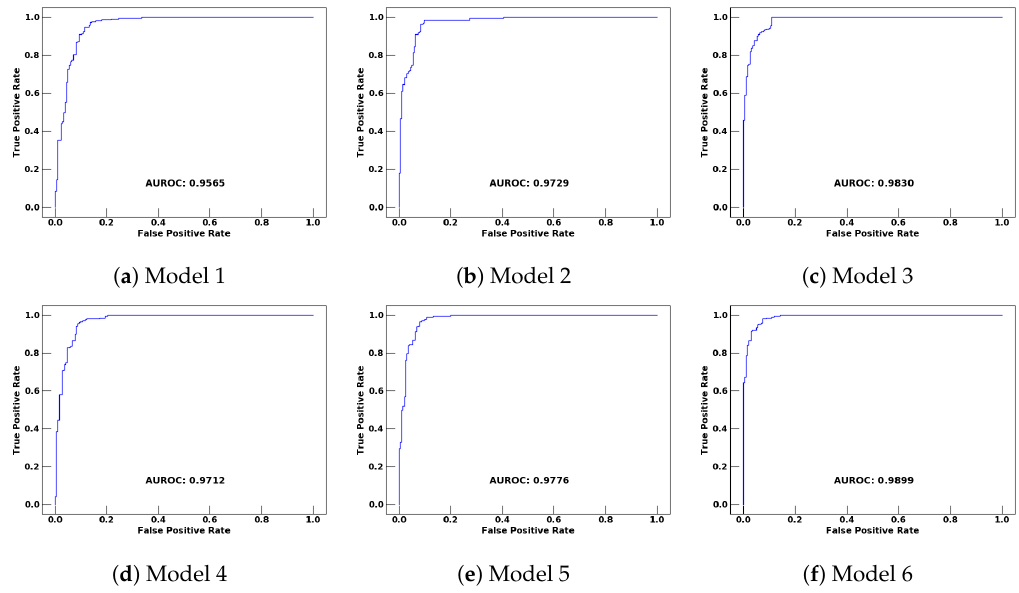
Figure 8. ROC curves of the models on 20% test